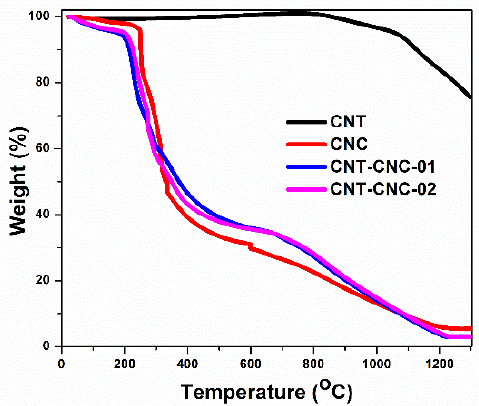
Figure 2. Thermogravimetric analysis data of carbon nanotube (CNT), crystalline nanocellulose (CNC), and CNT –